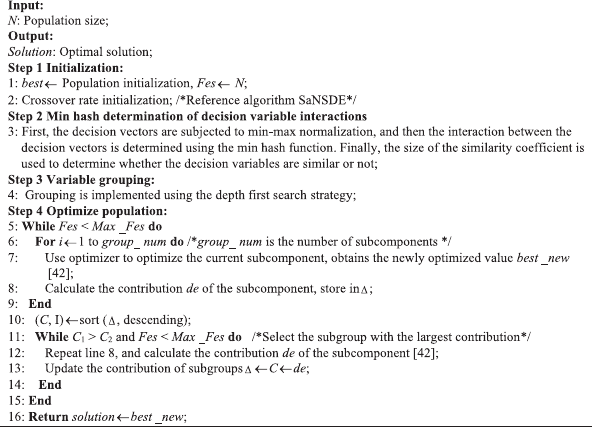
Frontiers in Energy Research |